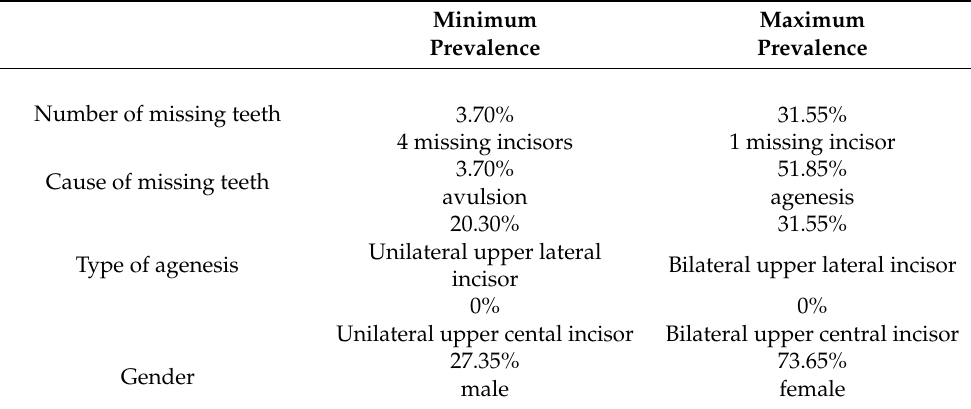
Table 1. Prevalence of maxillary incisor loss or agenesis.